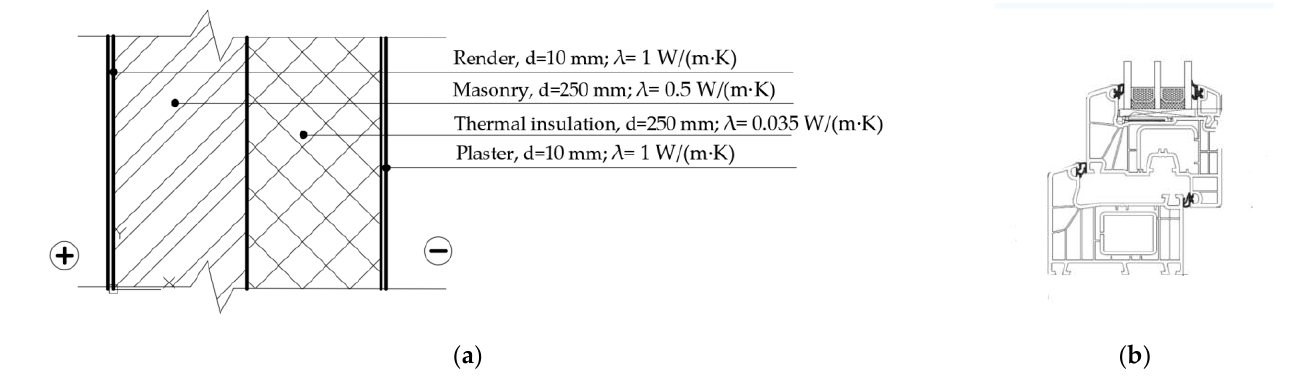
Figure 3. The scheme of the investigated wall structure ( a ) and of the investigated window frame ( b ). The wooden frame of the analyzed window consists of 6 chambers, and its thickness is 100 mm. The value of the thermal conductivity coefficient λ = 0.13 W/(m · K). The calculations were simplified and the heat exchange over the glass area was not detailed. The installation of a window on the wall’s opening using stone wool boards (SWB) was chosen for the study (Figure 4). The thermal conductivity coefficient of the special rigid SWB is λ = 0.059 W/(m · K). The window frame fastener W length is 192 mm; width— 50 mm; wall thickness—2 mm; thermal insulation thickness—48 mm. The length of the corner fastener CL of the thermal insulation panels (when the thickness of the thermal insulation layer was > 200 mm) is 192 mm; width—192 mm (respectively 96 mm on one side of the corner); wall thickness—2 mm. The thermal insulation board interconnect EL length was 192 mm; width—192 mm; wall thickness—2 mm. The investigation evaluated two wall installation fasteners measuring 80 × 100 mm. The calculations estimated one wall installation fastener measuring 80 × 100 mm. This method of installation does not require gaskets, as the thermal insulation material is flexible and allows the window frame to be installed tightly.